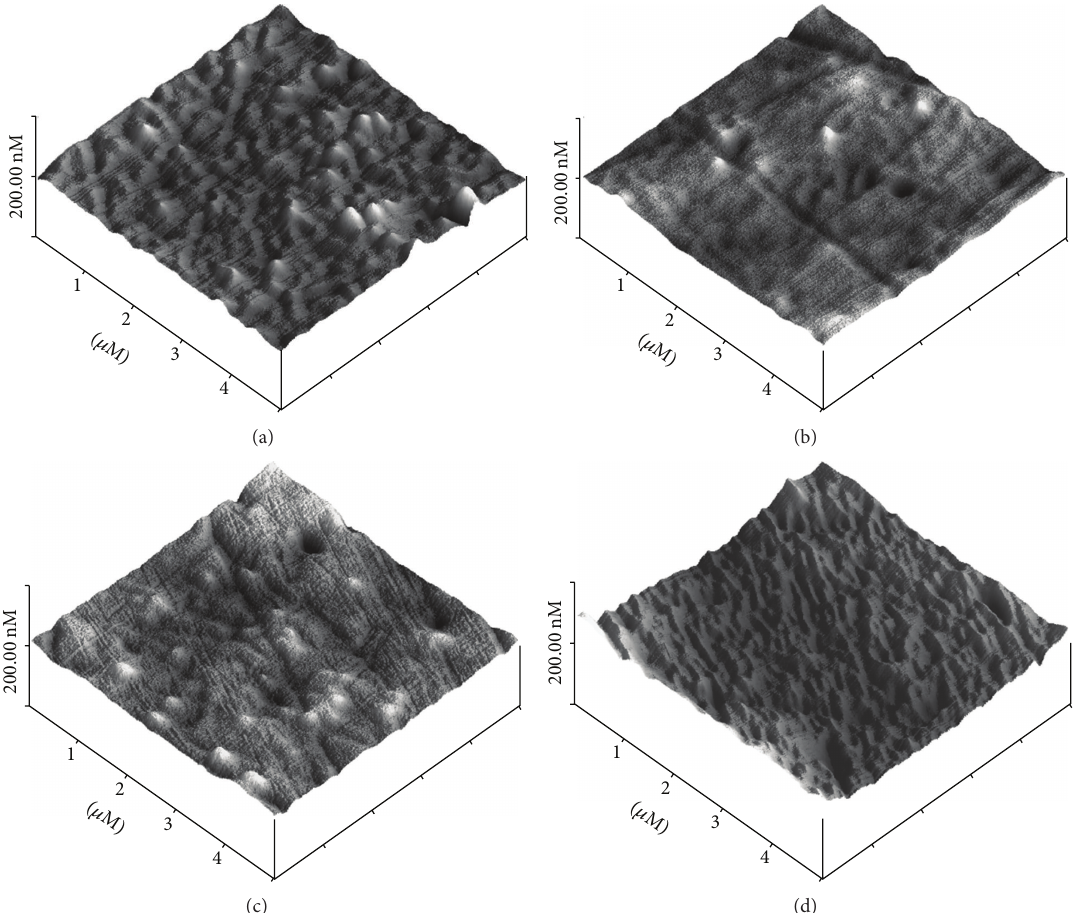
Figure 3: Three-dimensional AFM images of (a) a-SiC 0.59 :H, (b) a-SiC 0.75 :H, (c) a-SiC 0.89 :H, and (d) a-SiC 1.02 :H coatings on SS301 substrate.